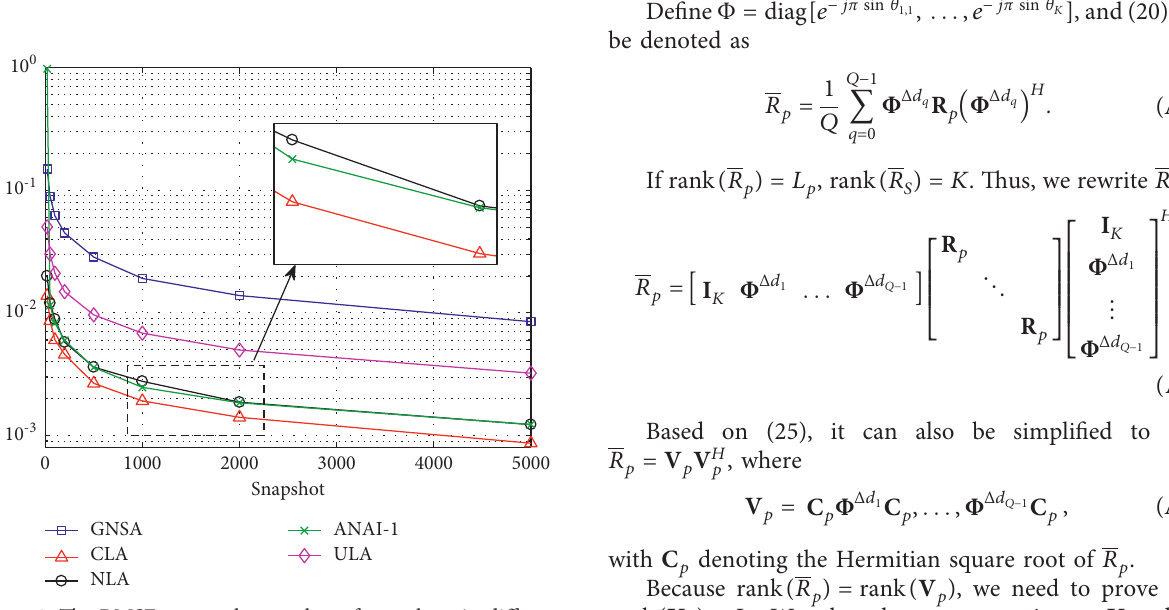
Figure 7: The RMSE versus SNR in different sparse arrays using FBSS.